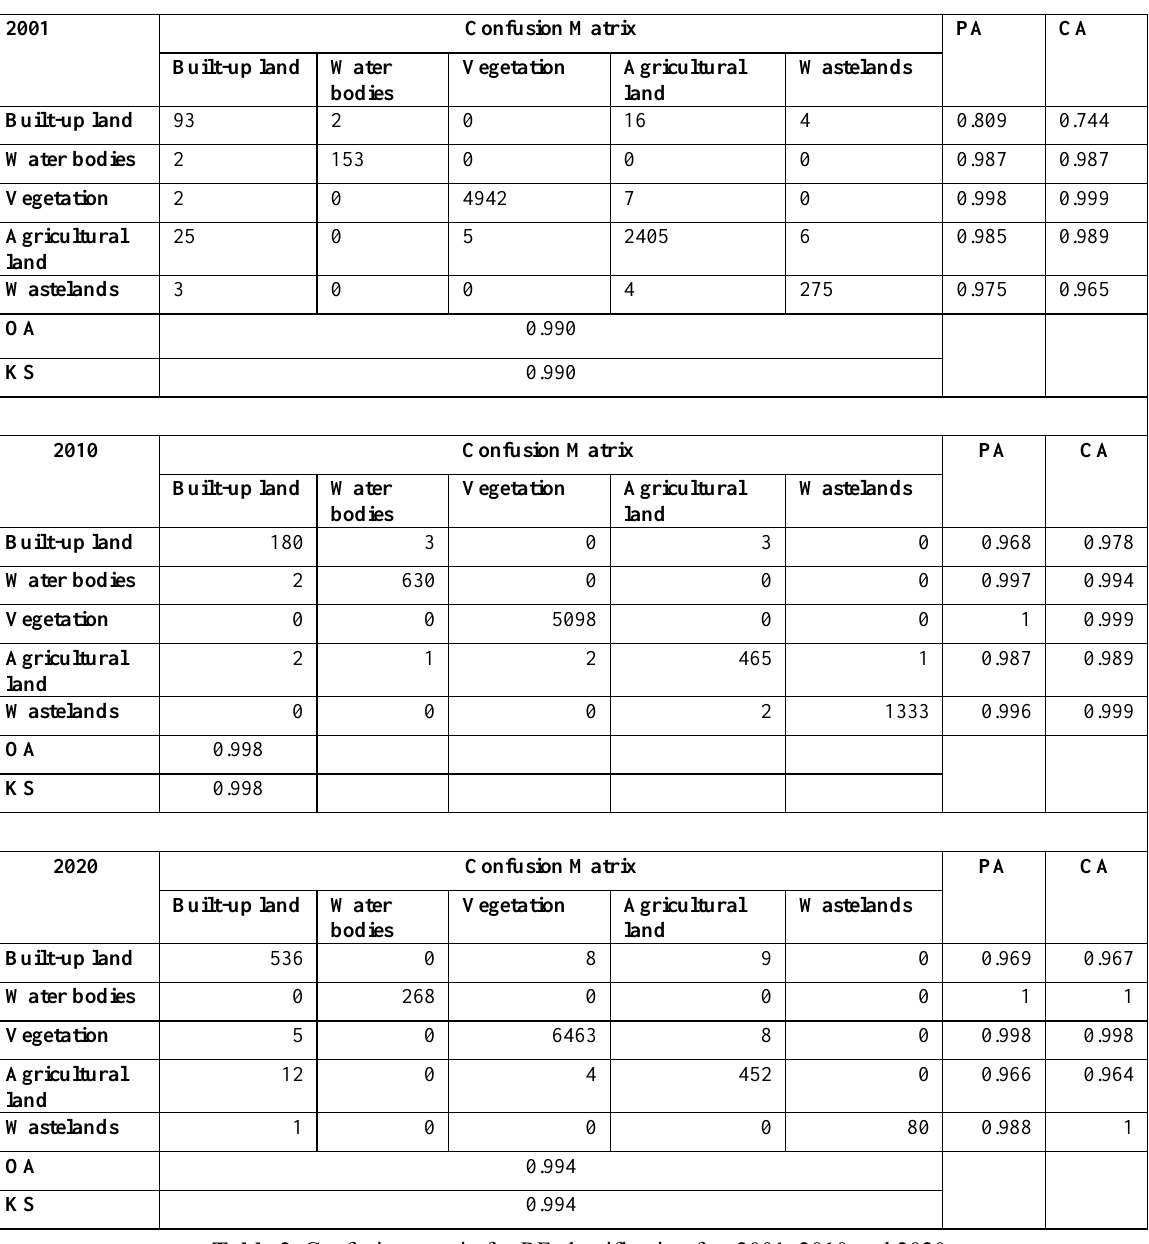
Table 2. Confusion matrix for RF classification for 2001, 2010 and